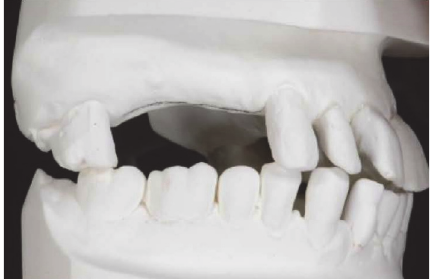
Figure 6: Analysis of edentulous space.